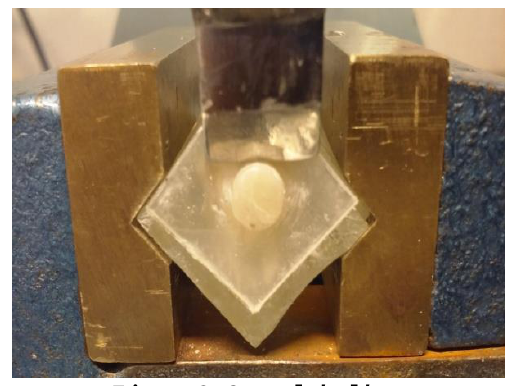
Figure 2: Sample holder.